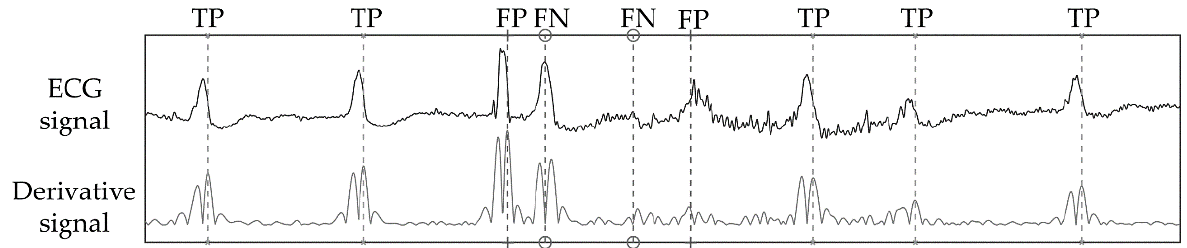
Figure 8. Detection markers for a strip of channel 2 in record 203 of the MIT-BIH Arrhythmia database. This is an example of a critical instance of signal, were both false positives and false negatives are generated.